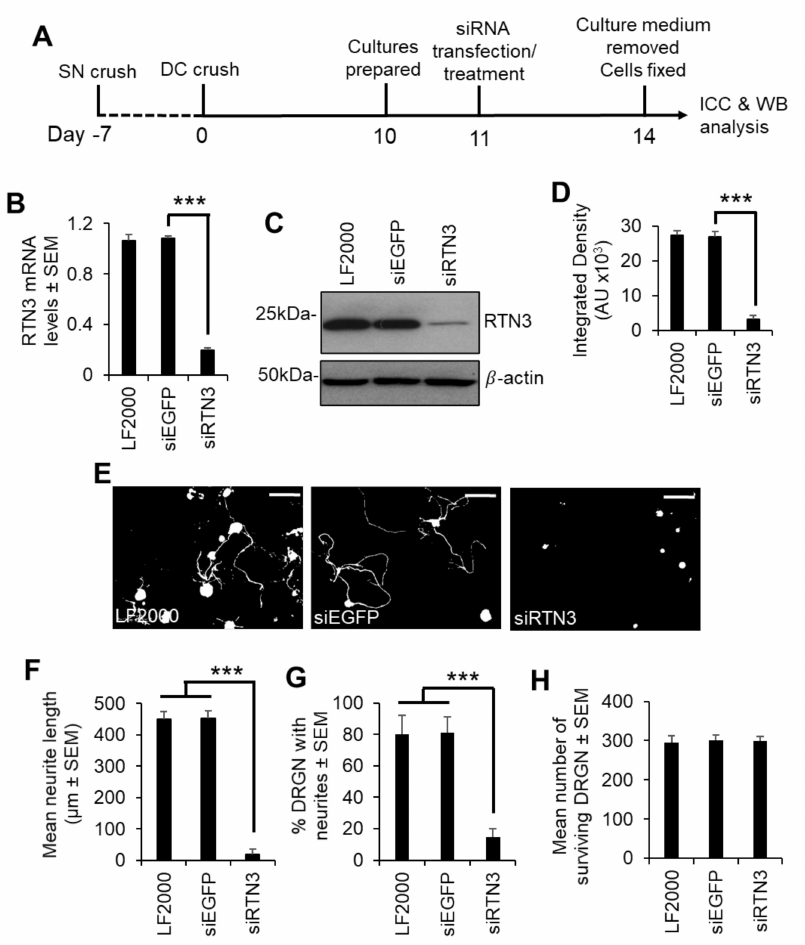
Figure 3. RTN3 is required for disinhibited DRGN neurite outgrowth. ( A ) Experimental timeline for analysis of RTN3 knockdown in preconditioned DRGN. ( B ) qRT-PCR to show ~80% knockdown of RTN3 using siRTN3. ( C ) Western blot to show levels of RTN3 protein after shRNA-mediated knockdown in DRGN. β -actin is used as a loading control. ( D ) Densitometry to show that PEI- shRTN3 significantly knocks down RTN3 protein in DRGN cultures. ( E ) Representative images to show neurite outgrowth after LF2000, siEGFP and siRTN3 treatment. ( F ) Quantification to show the mean longest neurite length after shRNA-mediated knockdown of RTN3. ( G ) Quantification to show % DRGN with neurites after shRNA-mediated knockdown of RTN3. ( H ) Quantification to show that DRGN survival is unaffected after shRNA-mediated knockdown of RTN3. Data are means ± SEM. Scale bars in ( E ) = 100 µ m. *** p = 0.0001, one-way ANOVA with Dunnett’s post